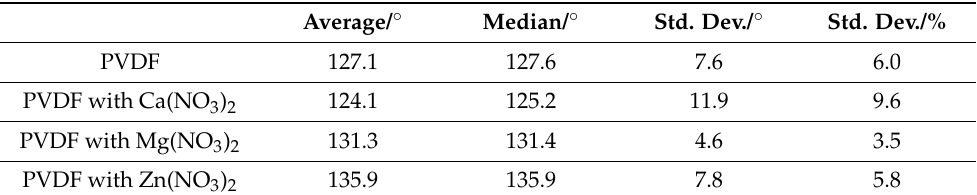
Table 1. Average, median and standard deviations for hydrophobicity measurement of pure PVDF fibers and PVDF with Ca(NO 3 ) 2 , Mg(NO 3 ) 2 and Zn(NO 3 ) 2 .